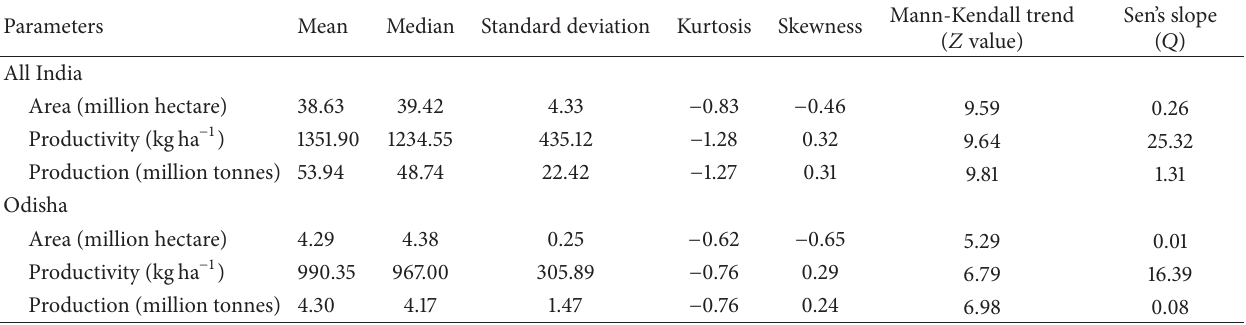
Mann-Kendall trend